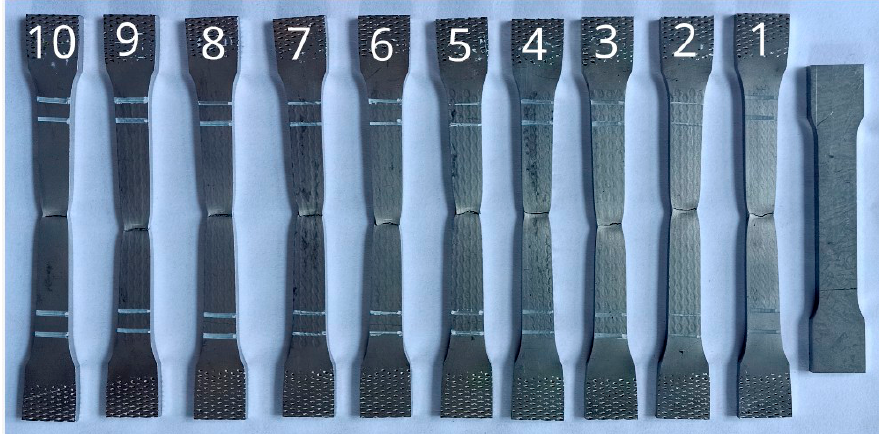
Figure 6. Broken standard tensile samples (no. 1–10) and standard tensile sample without